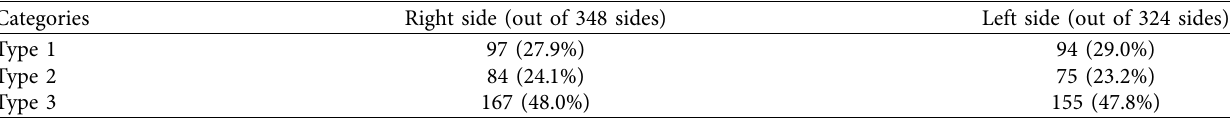
Table 2: Prevalence of anterior nerve looping in the study population as obtained by the bilateral split of mandible into right and left halves. Prevalence Prevalence of anterior nerve looping on the left side (out of 1200 sides examined) Prevalence of anterior nerve looping on the right side (out of 1200 sides examined) Overall prevalence of anterior nerve looping (out of 2400 sides examined) Table 3: Frequency distribution of anterior nerve loop on right and left sides based upon their types. Categories